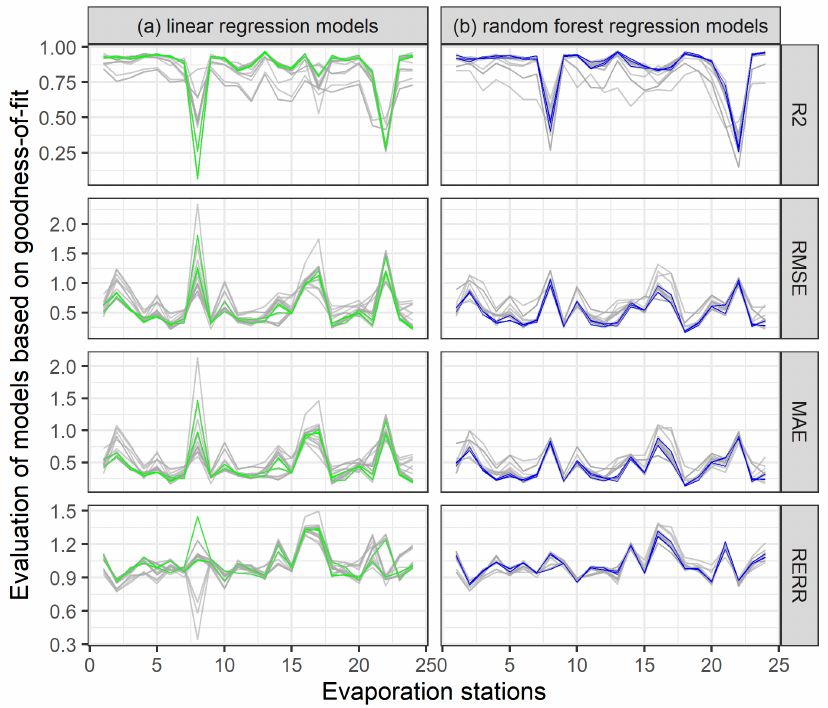
Figure 4. Evaluation of models using GOF, where the best models are selected. Part ( a ) linear regression models, green lines are LM1, LM7 and LM8. Part ( b ) random forest regression models, blue lines are RFM4, RFM5 and